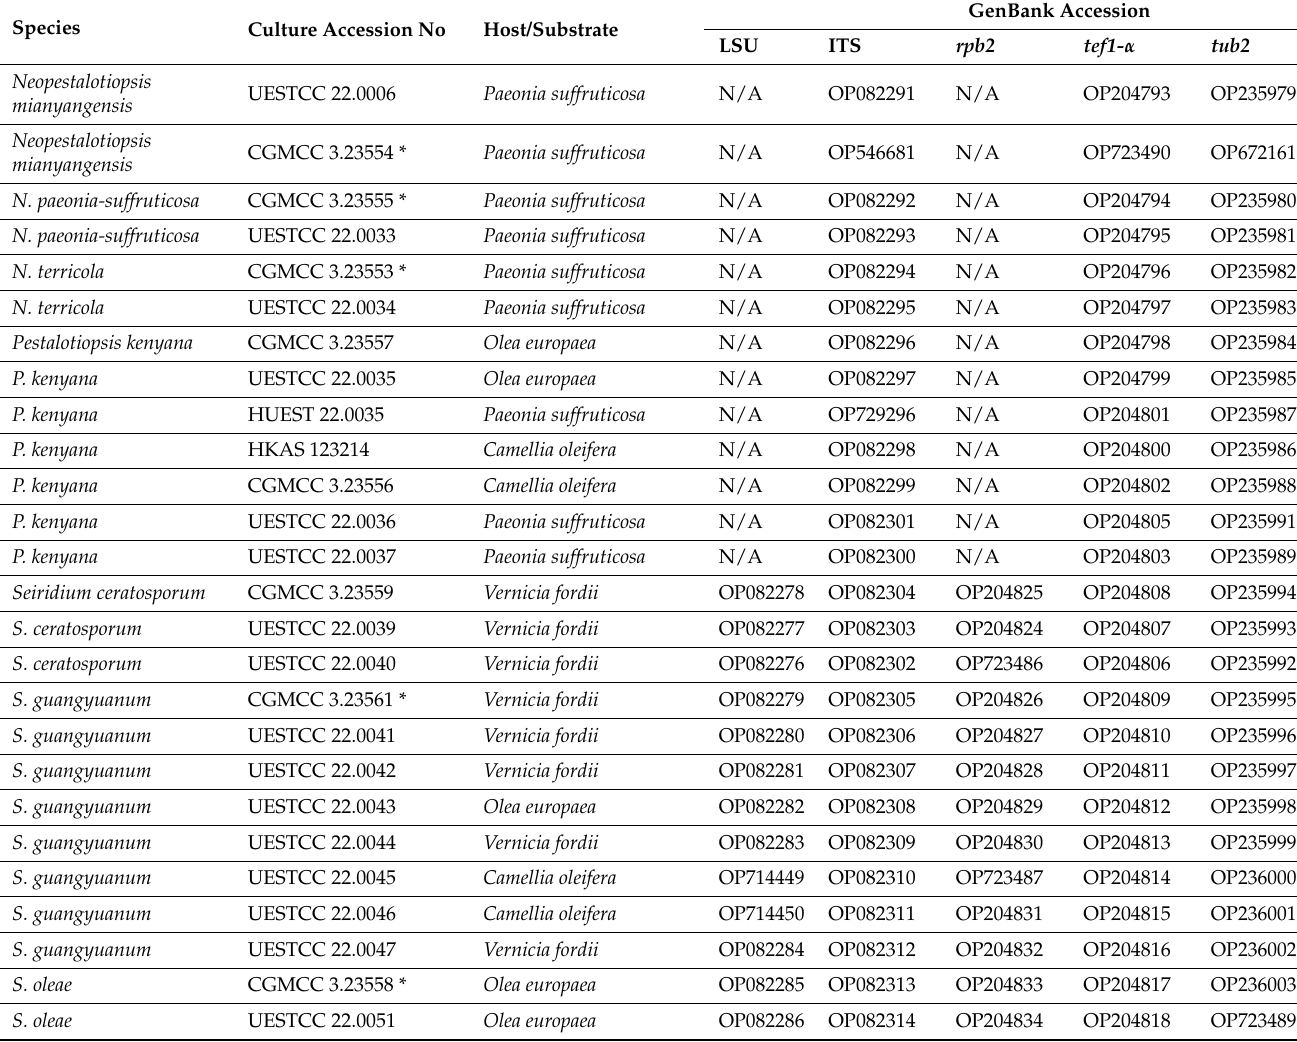
Table 1. Isolates and GenBank accession numbers of sequences obtained in this